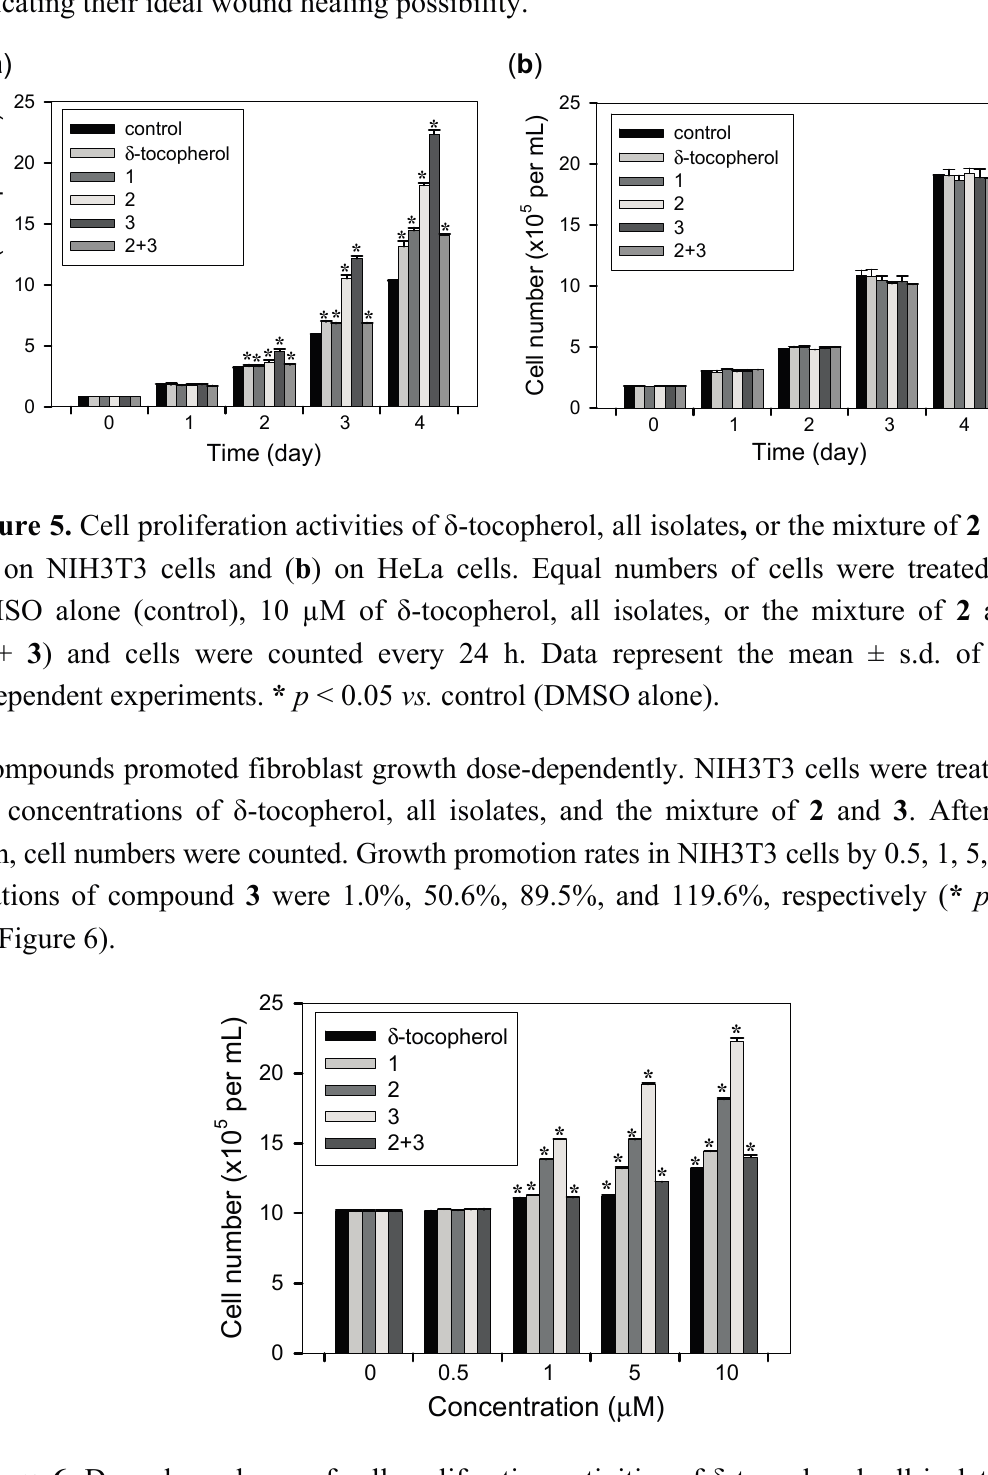
Figure 6. Dose-dependency of cell proliferation activities of δ -tocopherol, all isolates, or the mixture of 2 and 3 on NIH3T3 cells. Equal numbers of cells were treated with DMSO alone (control), indicated concentrations of δ -tocopherol, all isolates, or the mixture of 2 and 3 ( 2 + 3 ) and cells growth was determined after 4 days by counting cell numbers. Data represent the mean ± s.d. of three independent experiments. * p < 0.05 vs. control (0